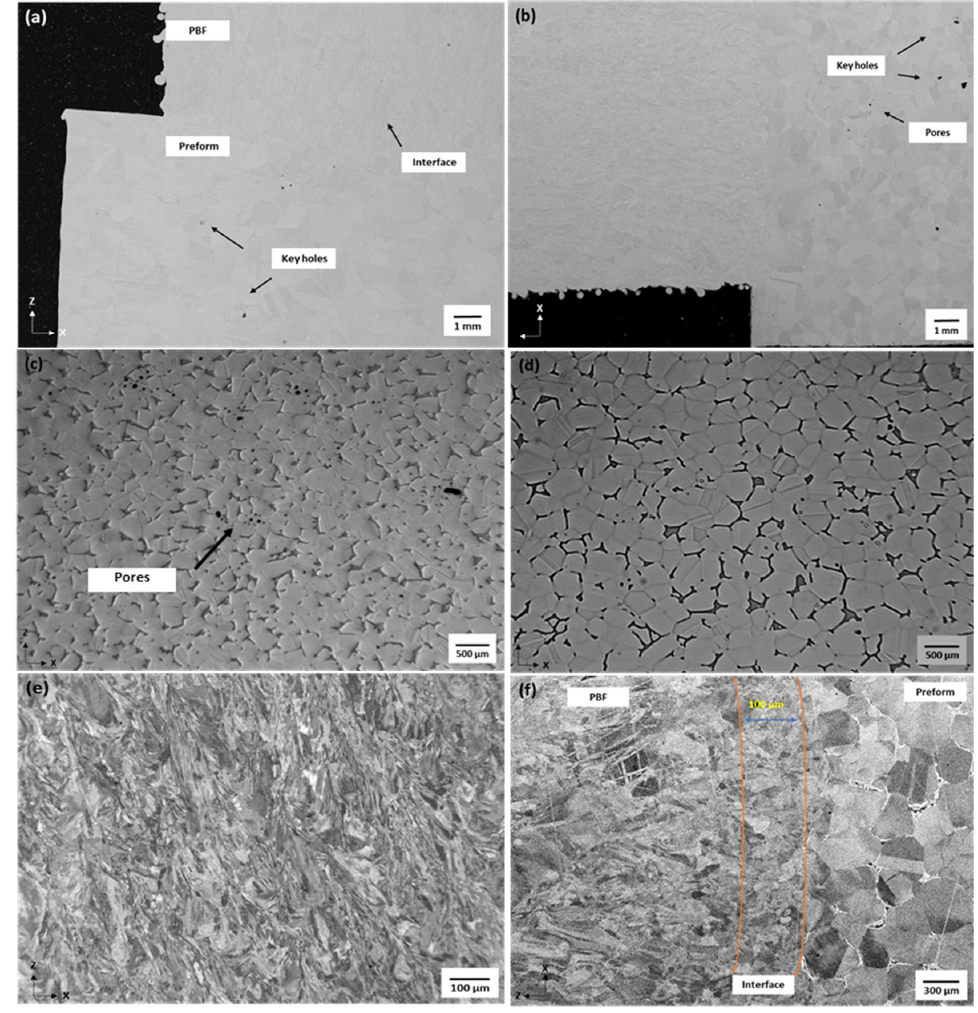
Figure 2. Cross sections of ( a ) as-built, ( b , c ) HT air-quenched, and ( d , f ) HIP samples. Arrows in ( a , b ) point at gas pores and keyholes. Higher magnification BSE-SEM images in ( c , d ) show the porosity state and grain growth, at the MIM preform in air-quenched and HIP samples, respectively. Higher magnification images ( e , f ) show the columnar and some equiaxed grains in the L-PBF section and the microstructural assimilation at the re-melt area/interface, respectively.